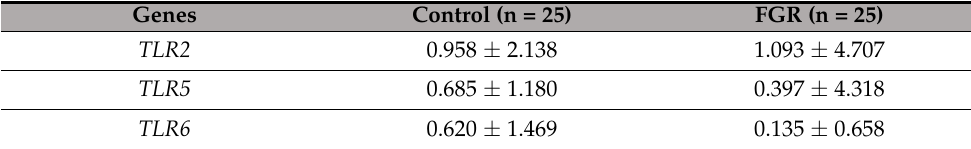
Table 4. Fluidigm Biomark TM Array showed the presence of PAMPs.